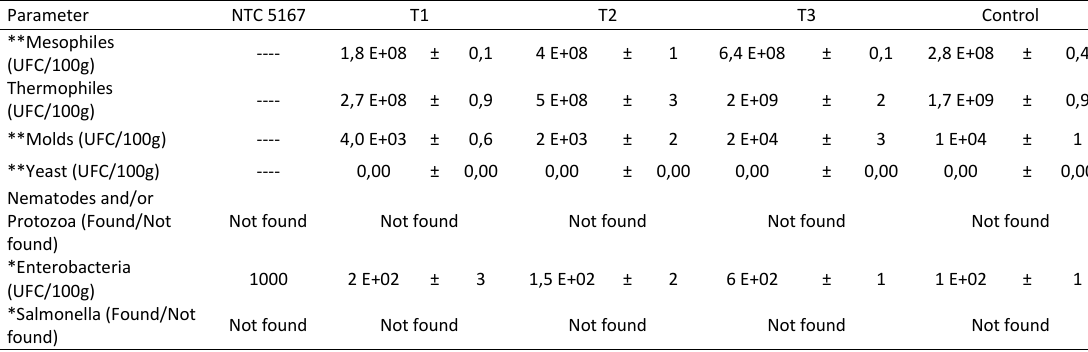
Table 4: Microbiological parameters by treatments